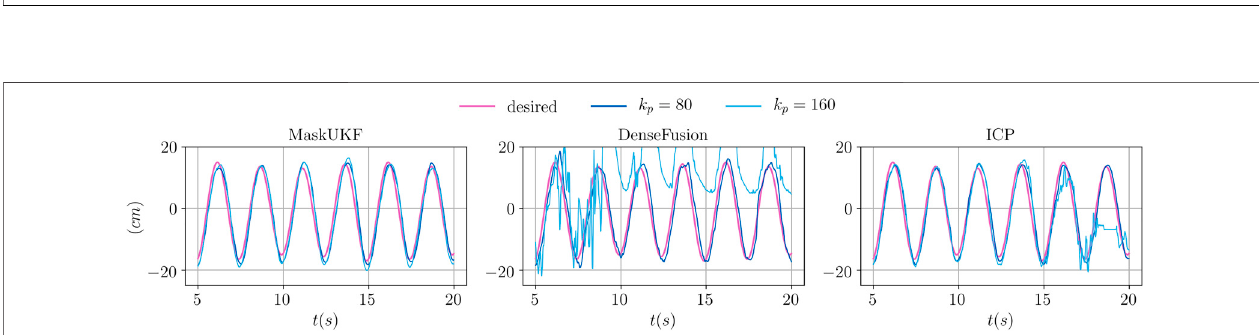
FIGURE 7 | Comparison between RMSE Cartesian and angular error for the object following experiment for varying proportional gains k p . Our method allows increasing the gain up to k p (cid:2) 320 reaching better tracking performance.